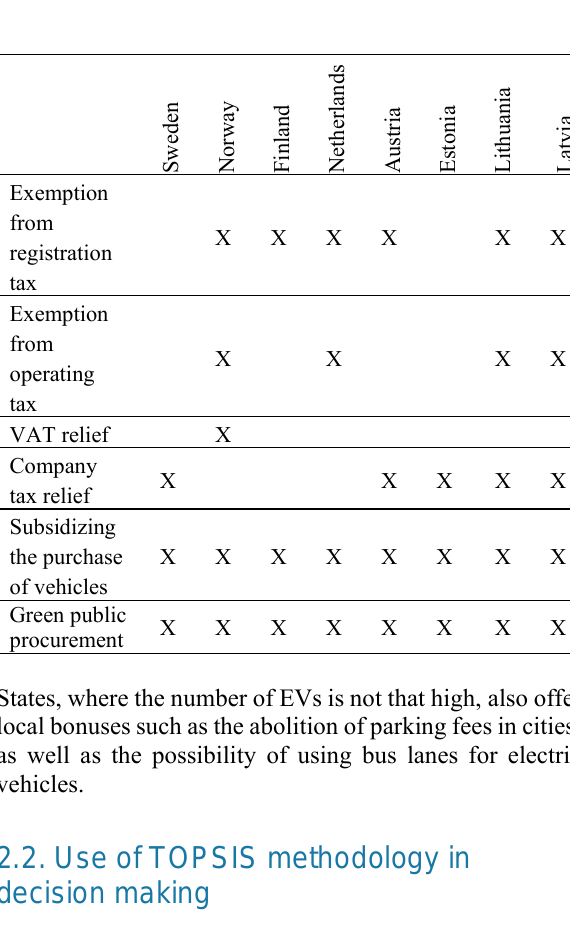
Table 1. Application of policy instruments in selected